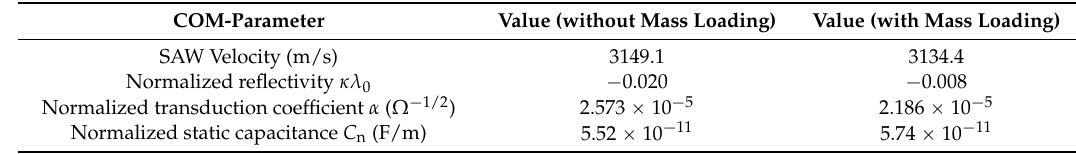
Table 3. COM parameters extracted by FEM for the structures without and with mass loading.